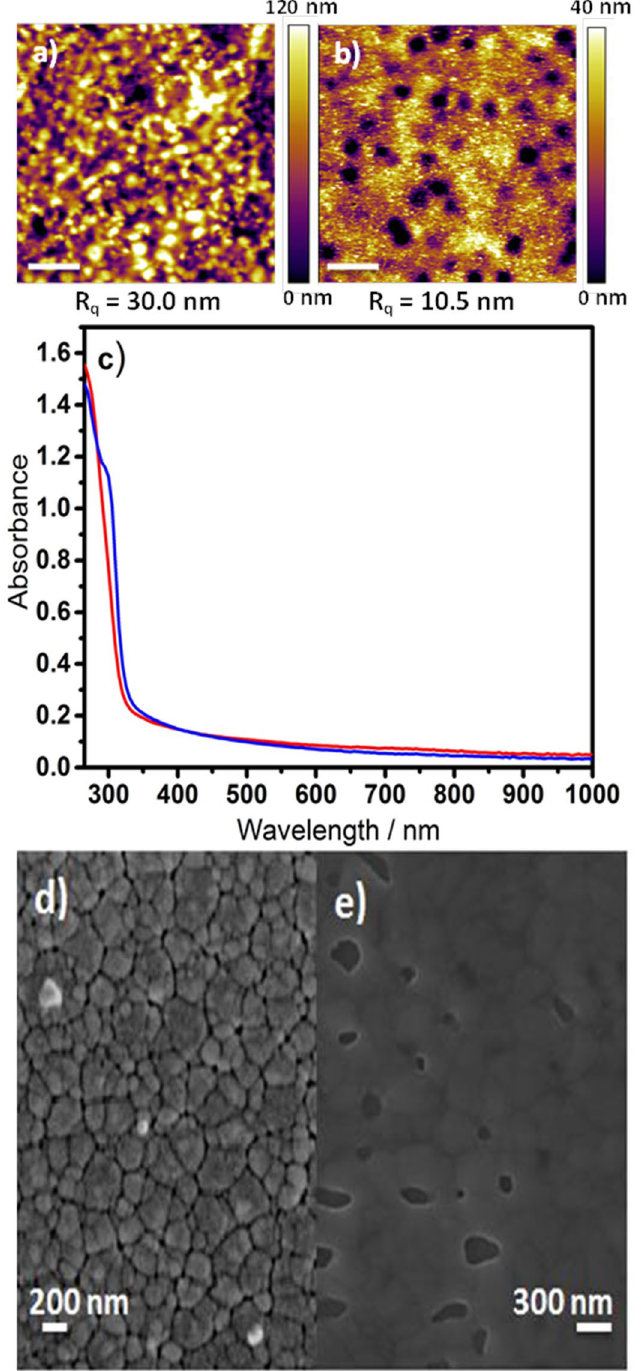
Figure 1. (Top): AFM image of surface topography of CuSCN film before ( a ) and after ( b ) DMF treatment. ( c ) Electronic absorption spectra of a spin cast CuSCN film (180–190 nm) on quartz before (red) and after (blue) washing with DMF by spin casting using the same deposition parameters as used for perovskite film deposition. (Bottom): SEM images of B- γ -CsSnI 3 + 10 mol% SnCl 2 deposited onto ITO glass with ( d ) and without ( e ) a CuSCN